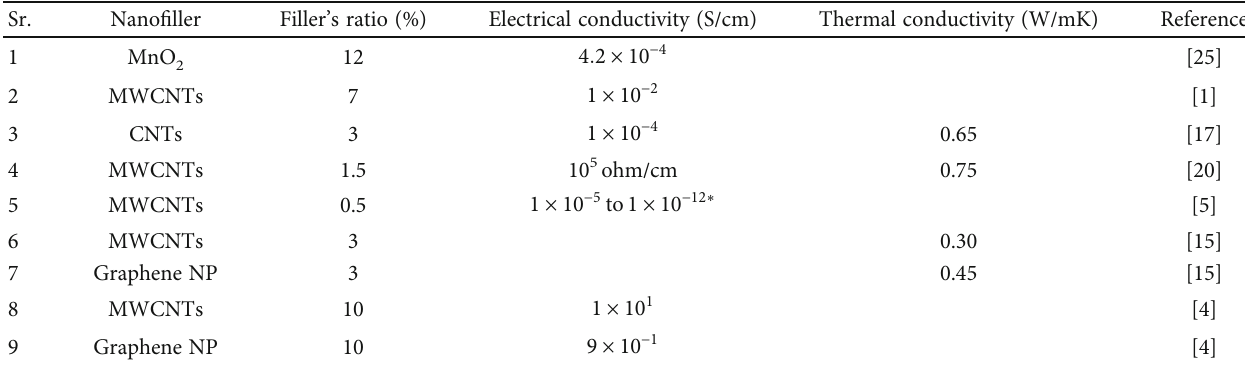
Table 1: Comparison of electrical and thermal properties of